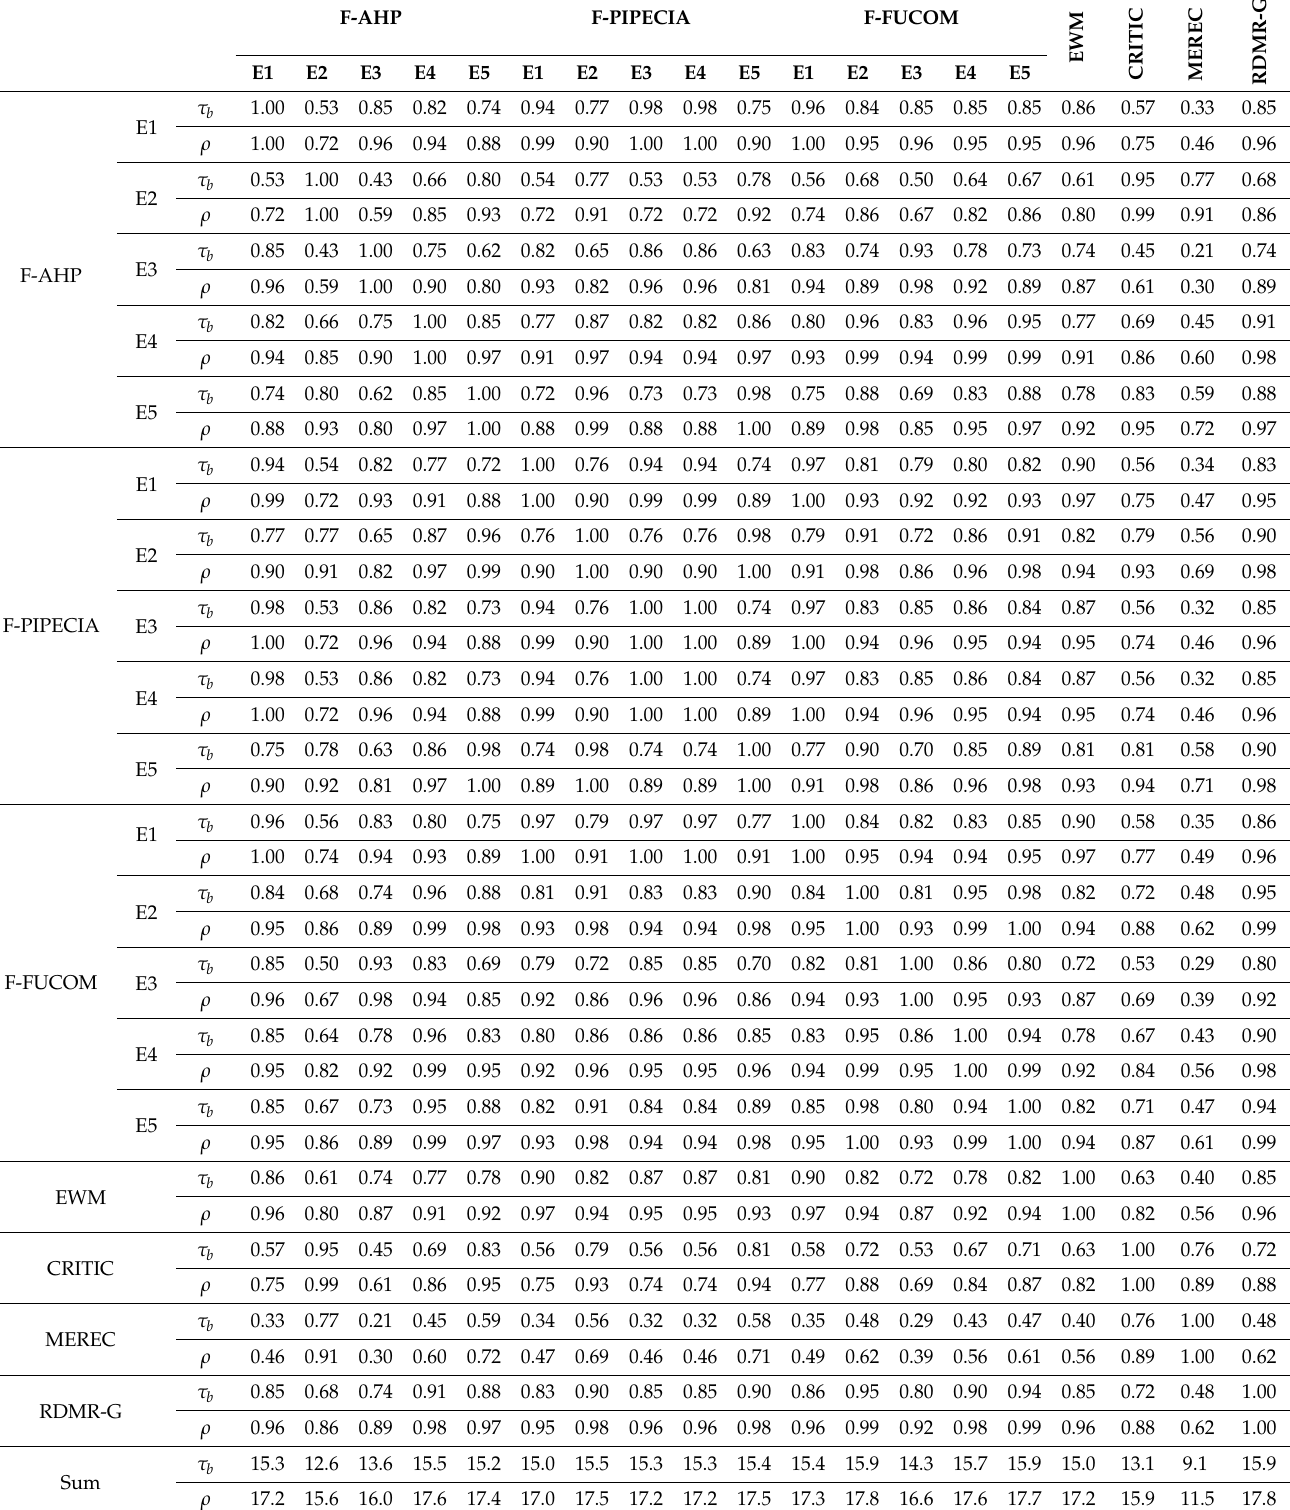
Table 6. Performance test results–Kendall’s and Spearman’s rank correlation